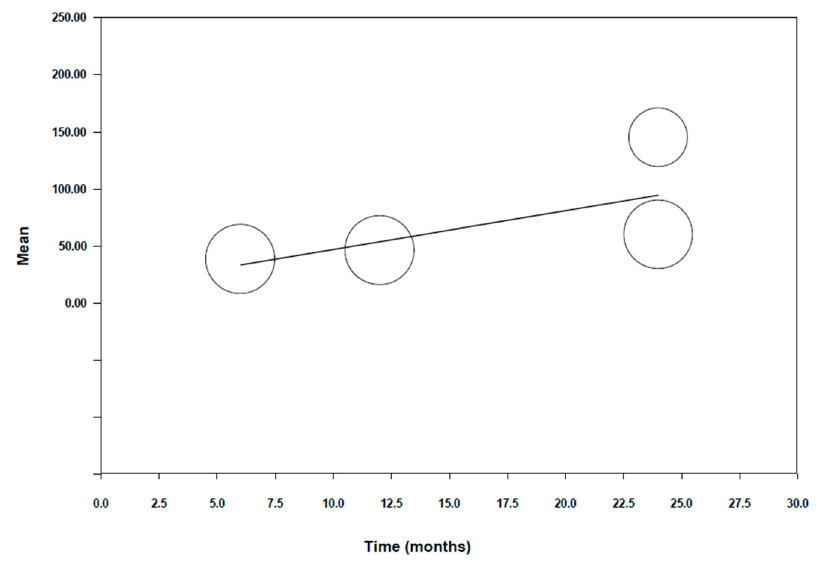
Figure 6. Graph depicting meta-regression for wear in monolithic zirconia vs. time.